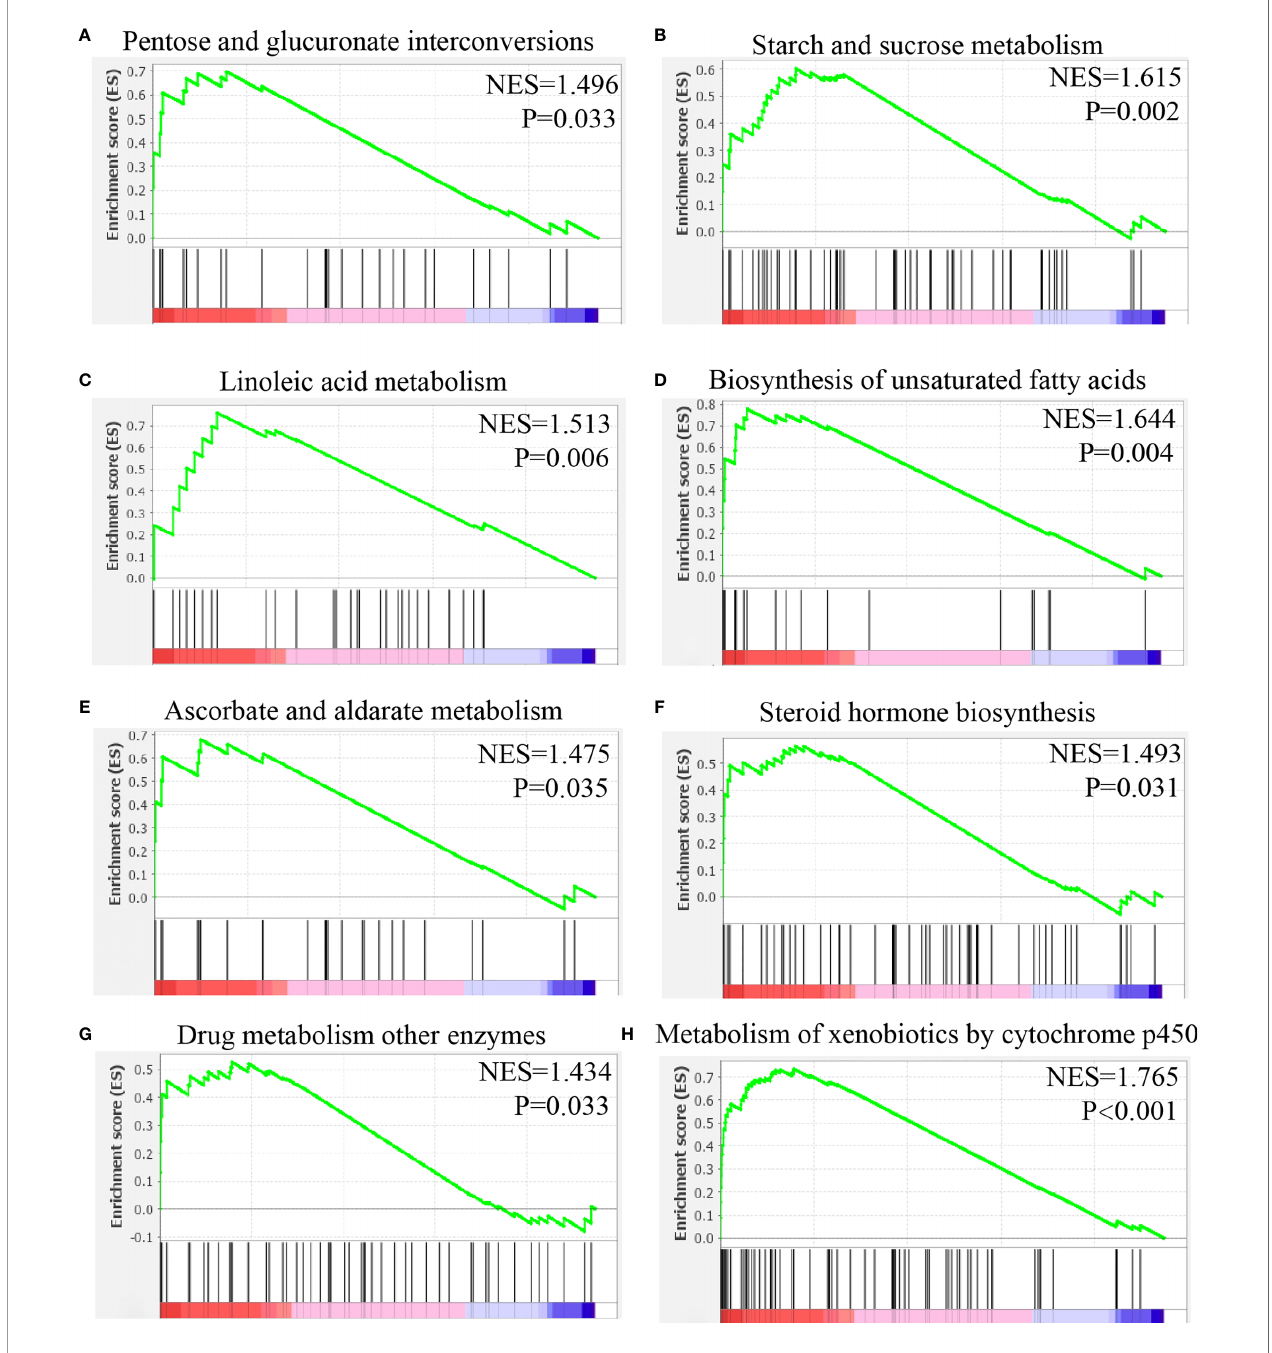
FIGURE 10 | Gene set enrichment analysis of CHRNB4 in malignant cells of HNSC. (A) The expression of CHRNB4 positively correlated with the pentose and glucuronate interconversions. (B) The expression of CHRNB4 positively correlated with the starch and sucrose metabolism. (C) The expression of CHRNB4 positively correlated with the linoleic acid metabolism. (D) The expression of CHRNB4 positively correlated with the biosynthesis of unsaturated fatty acids. (E) The expression of CHRNB4 positively correlated with the ascorbate and aldarate metabolism. (F) The expression of CHRNB4 positively correlated with the steroid hormone biosynthesis. (G) The expression of CHRNB4 positively correlated with the drug metabolism other enzymes. (H) The expression of CHRNB4 positively correlated with the metabolism of xenobiotics by cytochrome